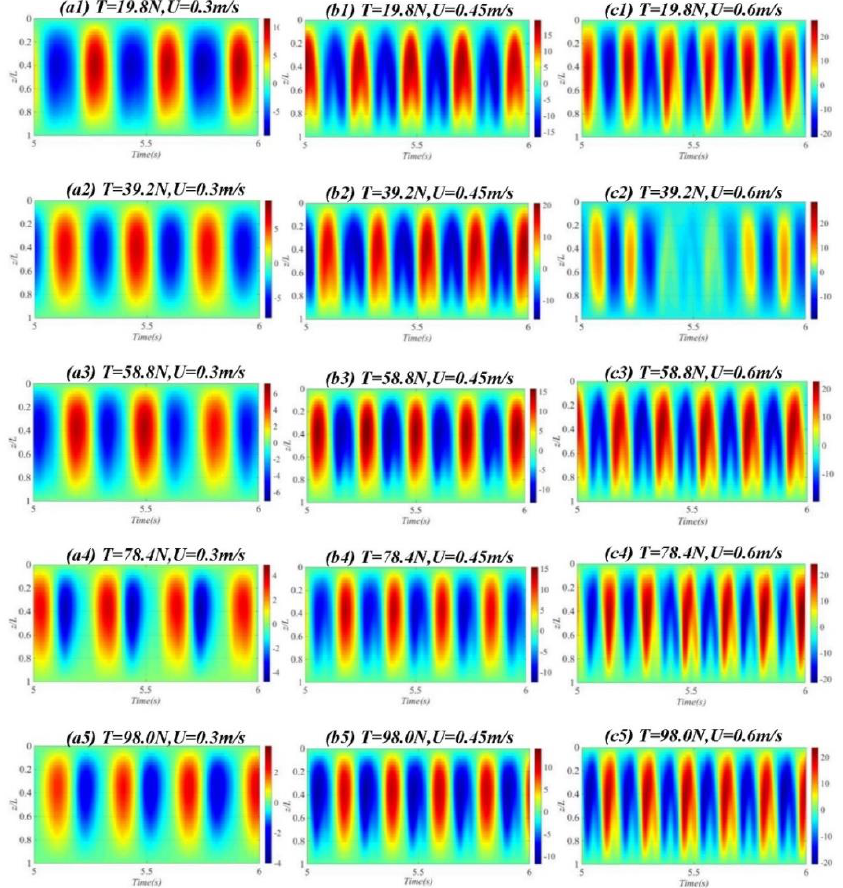
Figure 12. Time-varying graphs of riser dimensionless amplitudes at U = 0.3 m/s, U = 0.45 m/s, U = 0.6 m/s under different top tensions. ( a1 – a5 ) T = 19.8–98.0 N, U = 0.3m/s, dimensionless amplitude time-varying diagram of riser; ( b1 – b5 ) T = 19.8–98.0 N, U = 0.45 m/s, dimensionless amplitude time-varying diagram of riser; ( c1 – c5 ) T = 19.8–98.0 N, U = 0.6 m/s, dimensionless amplitude time-varying diagram of riser.